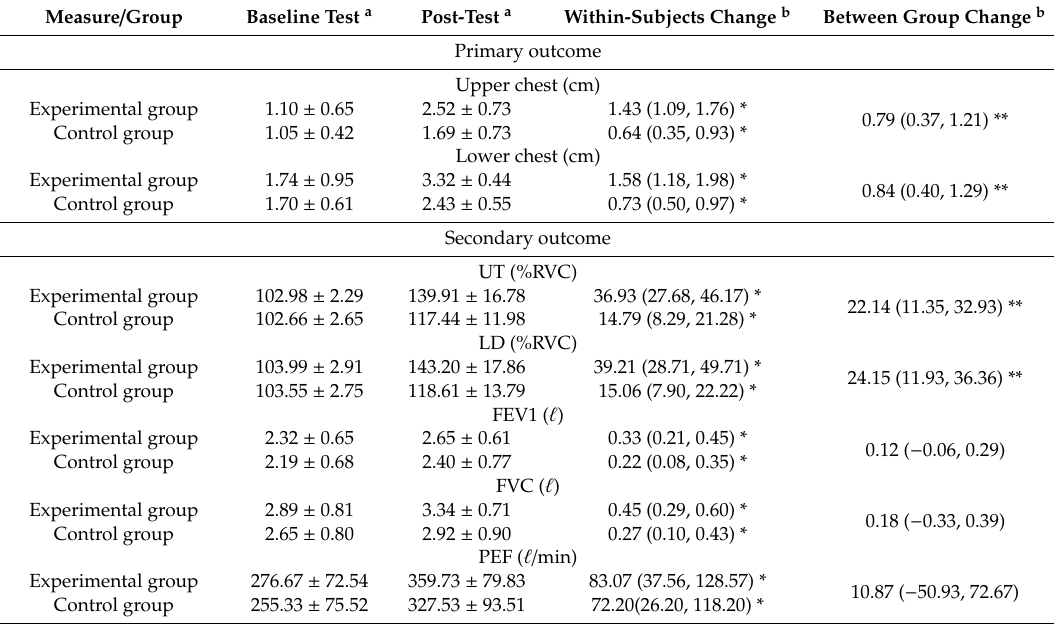
Table 2. Changes of in primary outcome and secondary outcome on two intervention